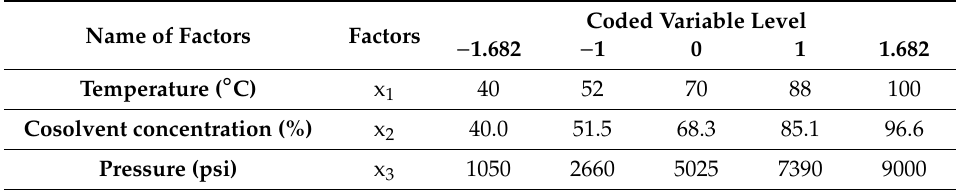
Table 1. The experimental design